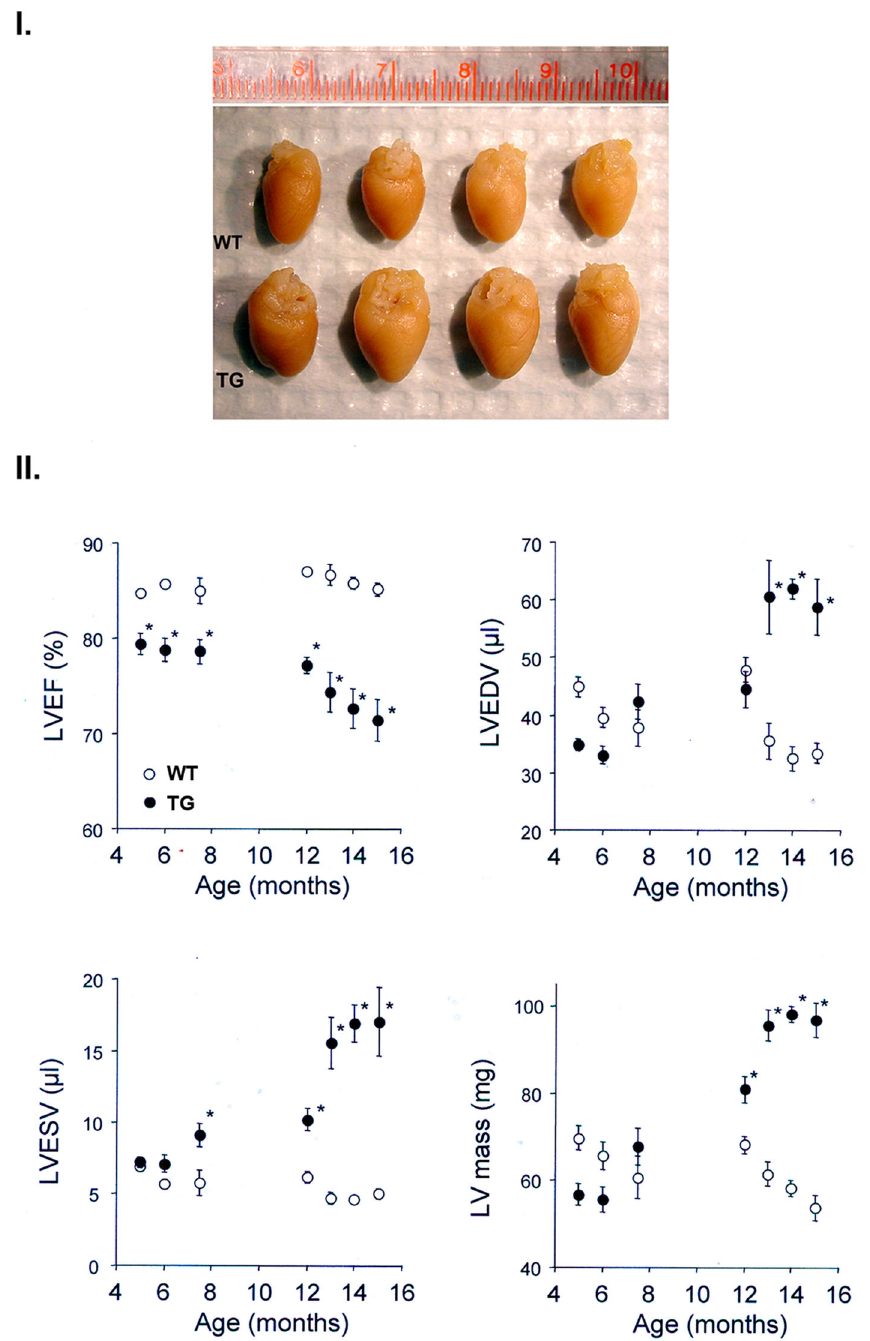
Figure 8. Gross cardiac morphology and serial non-invasive quantitation of cardiac function in NTT-MMP-2 transgenic mice. I. Formalin-fixed excised hearts from 12 month old WT and NTT-MMP transgenic mice. There is an approximate two-fold increase in the cardiac vertical and horizontal diameters in the NTT-MMP TG mice, which correlates with the measured increases cardiac mass. II. Serial changes in left ventricular ejection fraction (LVEF), LV end-diastolic volume (LVEDV), LV end-systolic volume (LVESV) and LV mass as determined by echocardiography are shown. Two cohorts of mice (WT and TG) were studied serially over 5-8 months of age and two other cohorts (WT and TG) were studied serially between 12 and 15 months of age. Comparisons were made at each time point using an unpaired t-test (n = 5–6 for each cohort; * P<0.05).